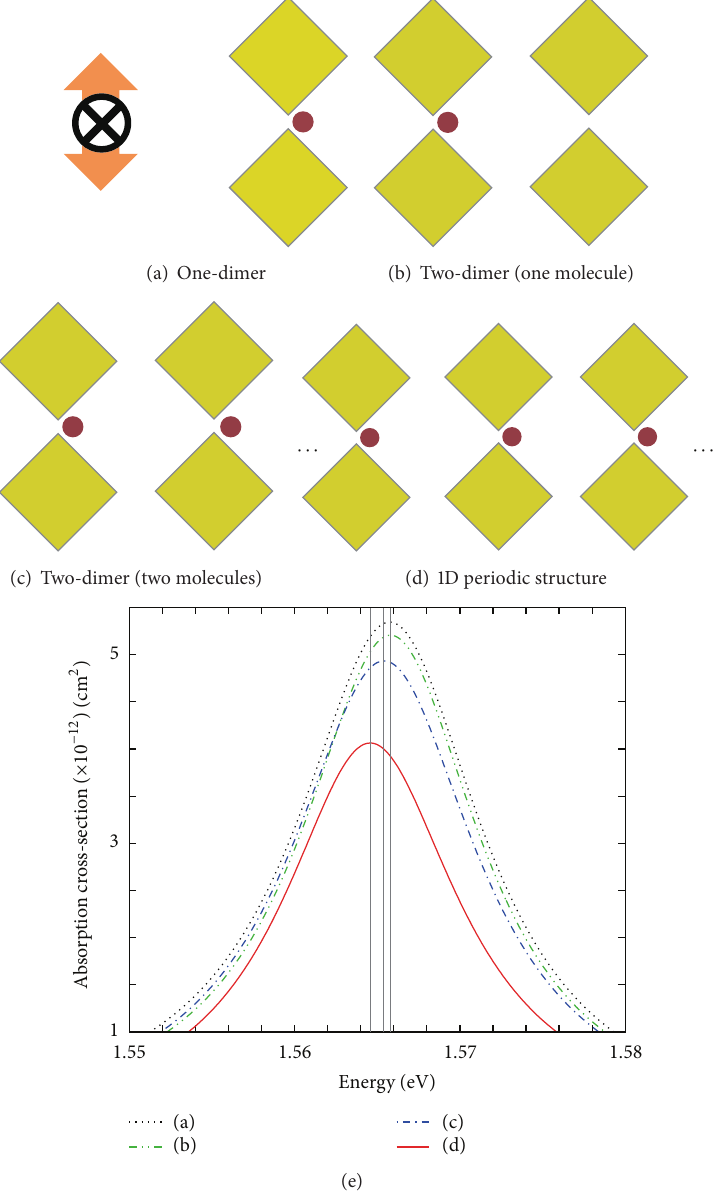
Figure 3: (a) Top view of the arrangement of the dimeric antennas and the molecule; here the spacing between the blocks is changed to be 3 nm according to the convenience in the calculation. (b-c) Top view: two sets of the dimeric antennas and one and two molecules, respectively. (d) Top view of the periodic 1D array of the dimeric antenna-molecule coupled system. (e) The absorption cross-section is plotted for each arrangement pattern; one can see that, in the 1D periodic array, the largest red-shift ∼ 1.2meV is induced due to the radiation-induced intermolecule correlation, which exceeds the one due to the antenna-molecule